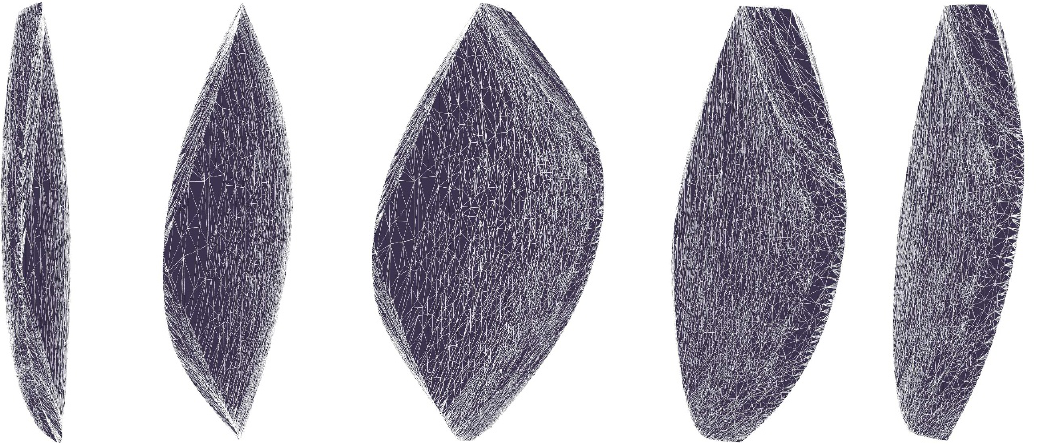
Figure 1 . S-matrix monolith for O(7) and s (cid:3) = 3 m 2 . The best way to feel | quite literally | the various vertices, pre-vertices, edges and faces of the monolith is to 3D print it. We can easily detect nearly imperceptible vertices with one’s (cid:12)ngertips [1], see also (cid:12)gure 9 below. We attach an ancillary (cid:12)le 3dPrint.stl made out of a discretization of the monolith with more than 200,000 points (using the method of normals explained below) which can be directly printed or very e(cid:14)ciently visualized. 3 To generate such 3D printing (cid:12)le for the convex monolith is quite simple. We generate a huge list of points belonging to the monolith and then create the convex hull of all these points using Mathematica ’s built-in function ConvexHullMesh which can then be exported directly into an .stl